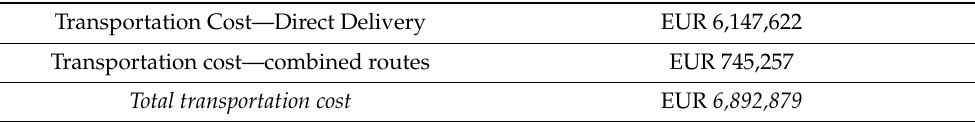
Table 5. Total annual NH 3 distribution costs of model